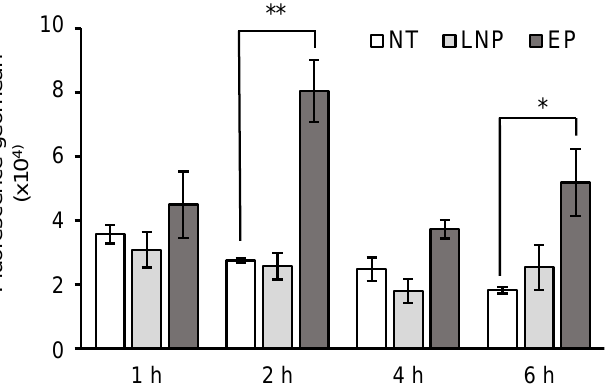
Figure 4. Integrated stress responses induced by the transfection. The phosphorylation level of the eIF2 α was compared. Jurkat cells were fixed and permeabilized after the transfection. The intracel- lular amount of phosphorylated eIF2 α was evaluated by an anti-phosphorylated eIF2 α antibody. The phosphorylation level of the eIF2 α of LNP ssPalm and electroporation (EP) was compared to the non-treated cells (NT). Data were represented as mean ± SD ( n = 3). Statistical analyses were performed by One-way ANOVA followed by Tukey–Kramer test, *; p < 0.05 against non-treated group **; p < 0.01 against non-treated group.